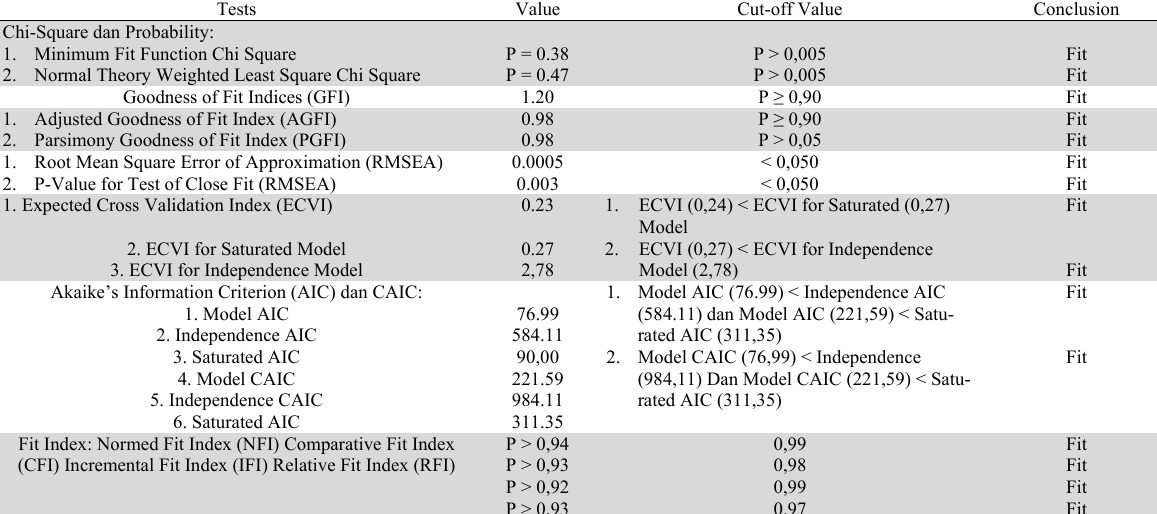
Result of Goodness of Fit Test Tests Value Cut-off Value Conclusion Chi-Square dan